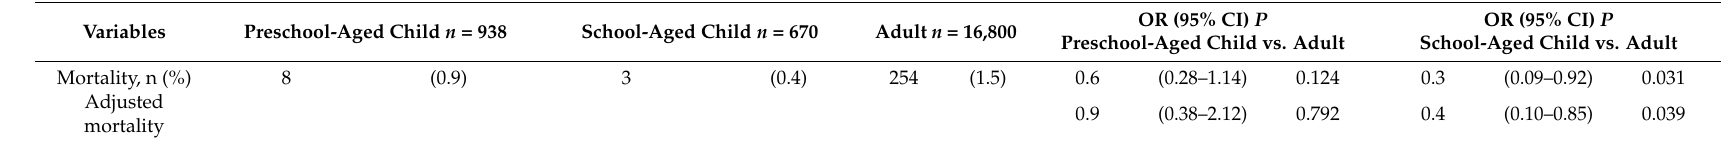
Table 4. Outcomes of categorical variables in preschool-aged children, school-aged children, and